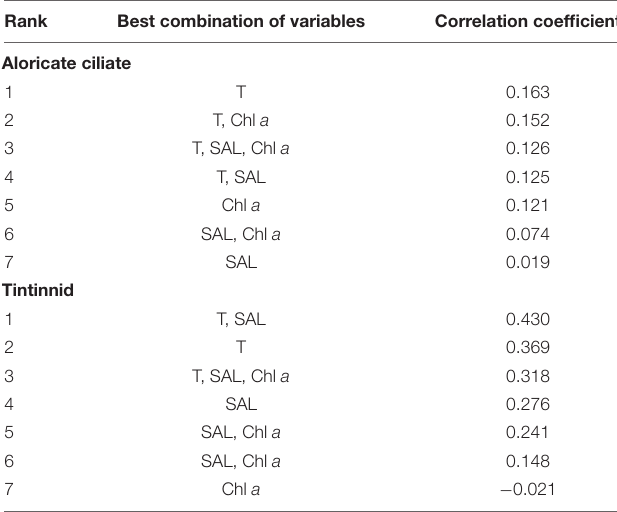
TABLE 3 | Summary of results from BIOENV (biota-environment) analysis showing the best matches of combinations of environmental variables with variations in aloricate ciliate and tintinnid